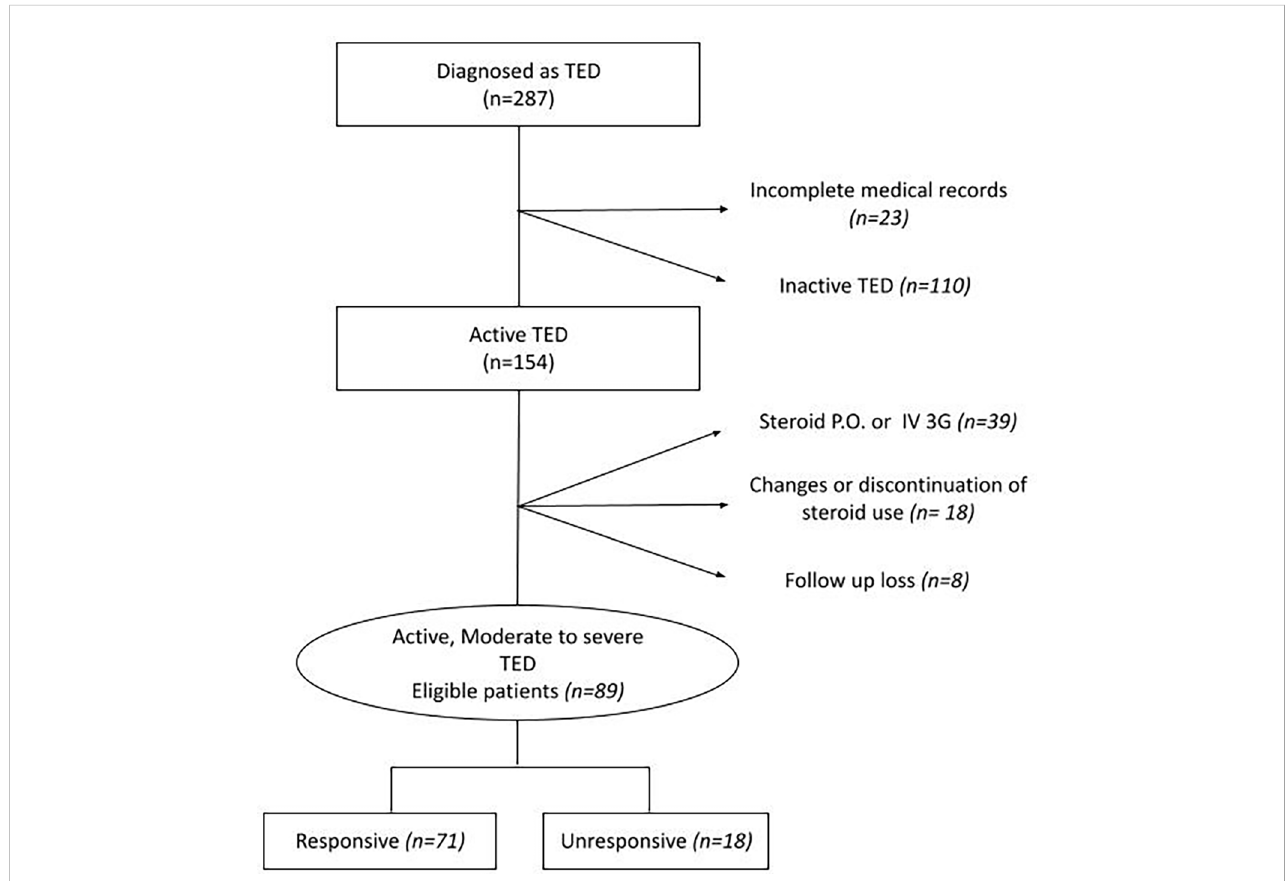
FIGURE 1 Flow chart of the data extraction. P.O., per oral; TED, thyroid eye disease; IV, intravenous; 3G, 3